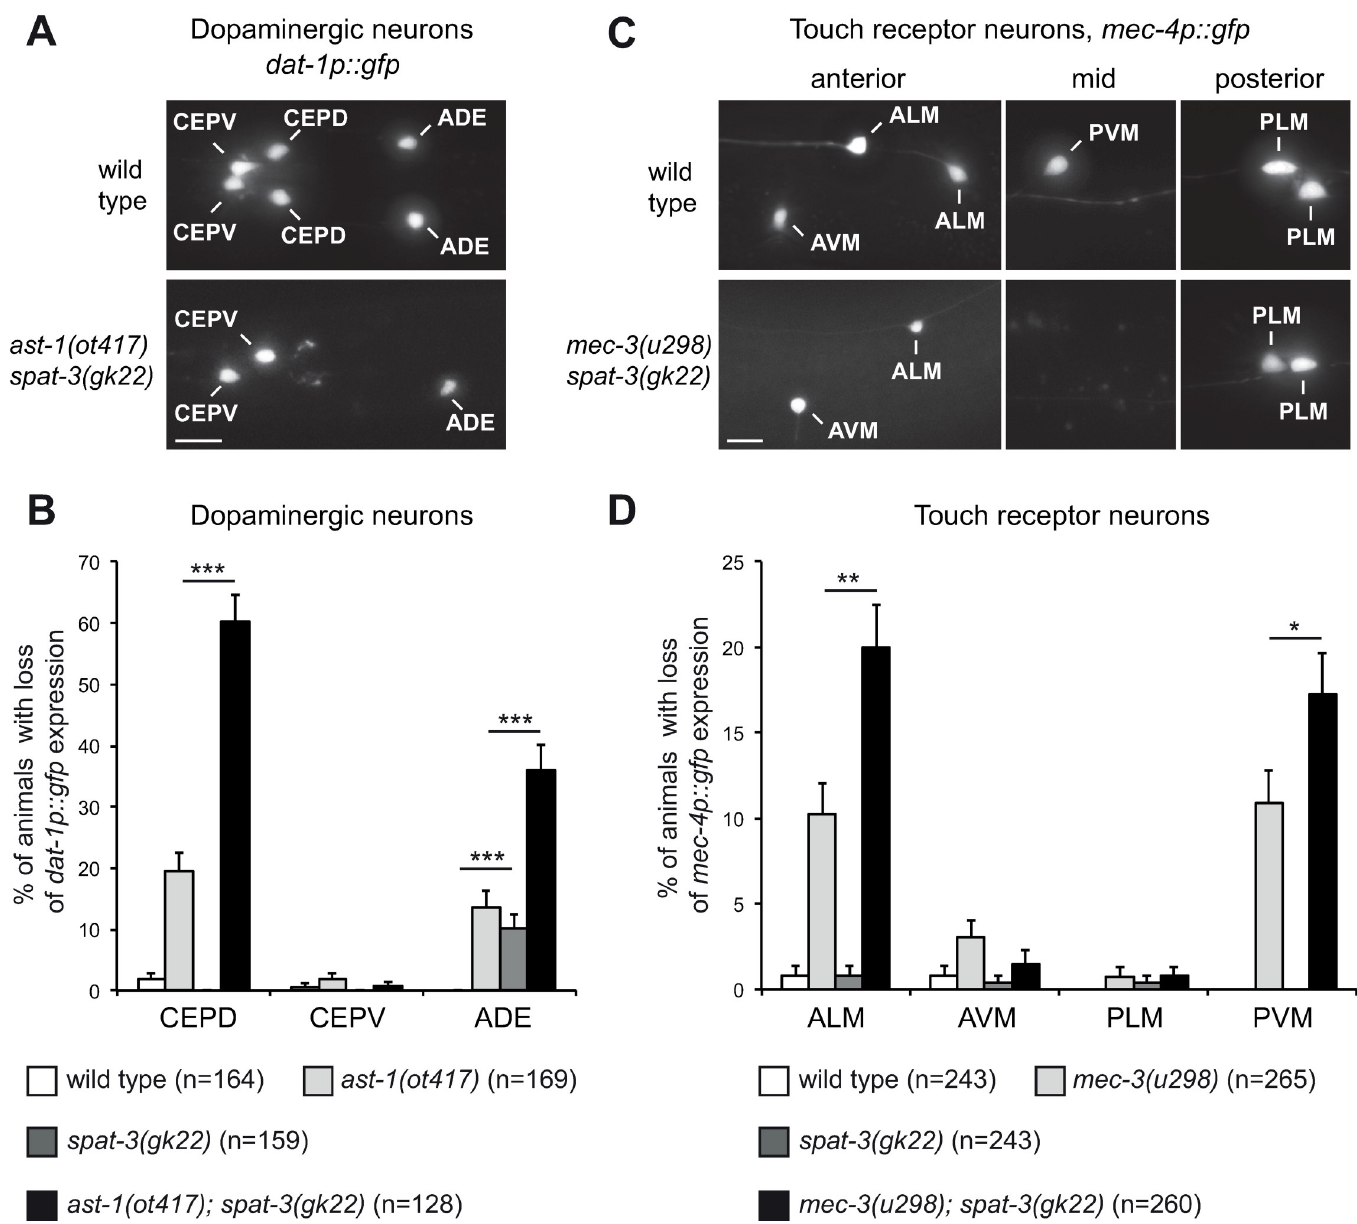
Fig 9. Effect of PRC1 on dopaminergic neurons and touch receptor neurons. (A) Expression of the dopaminergic marker ( dat-1p :: gfp , vtIs1 ) in the head of an early larva. In wild type animals expression is observed in the 6 dopaminergic neurons of the head (2 CEPV, 2 CEPD, 2 ADE). In ast-1(ot417); spat-3(gk22) double mutants expression is lost in some CEPD and ADE (expression lost in the two CEPD and one of the ADE in this example). Dorsal views, anterior is left, scale bar = 5 μ m. (B) Percentage of early larvae that display for each class of head dopaminergic neurons a loss of dat-1p :: gfp ( vtIs1 ) expression in at least one neuron (error bars show standard error of proportion, n = number of animals analyzed, ��� p < 0.001, Fisher’s exact test). (C) Expression of the touch receptor neuron marker ( mec-4p :: gfp , zdIs5 ) in the anterior, mid and posterior regions of late larvae (L4). In wild type animals expression is observed in the 6 touch receptor neurons (2 ALM, 1 AVM, 2 PLM, 1 PVM). In mec-3(u298); spat-3(gk22) double mutants expression is lost in some ALM and PVM (expression lost in one of the two ALM and in PVM in these examples). Lateral views, anterior is left, scale bar = 5 μ m. (D) Percentage of late larvae (L4) that display for each class of touch receptor neurons a loss of mec-4p :: gfp ( zdIs5 ) expression in at least one neuron (error bars show standard error of proportion, n = number of animals analyzed, � p < 0.05, �� p < 0.01 Fisher’s exact test).